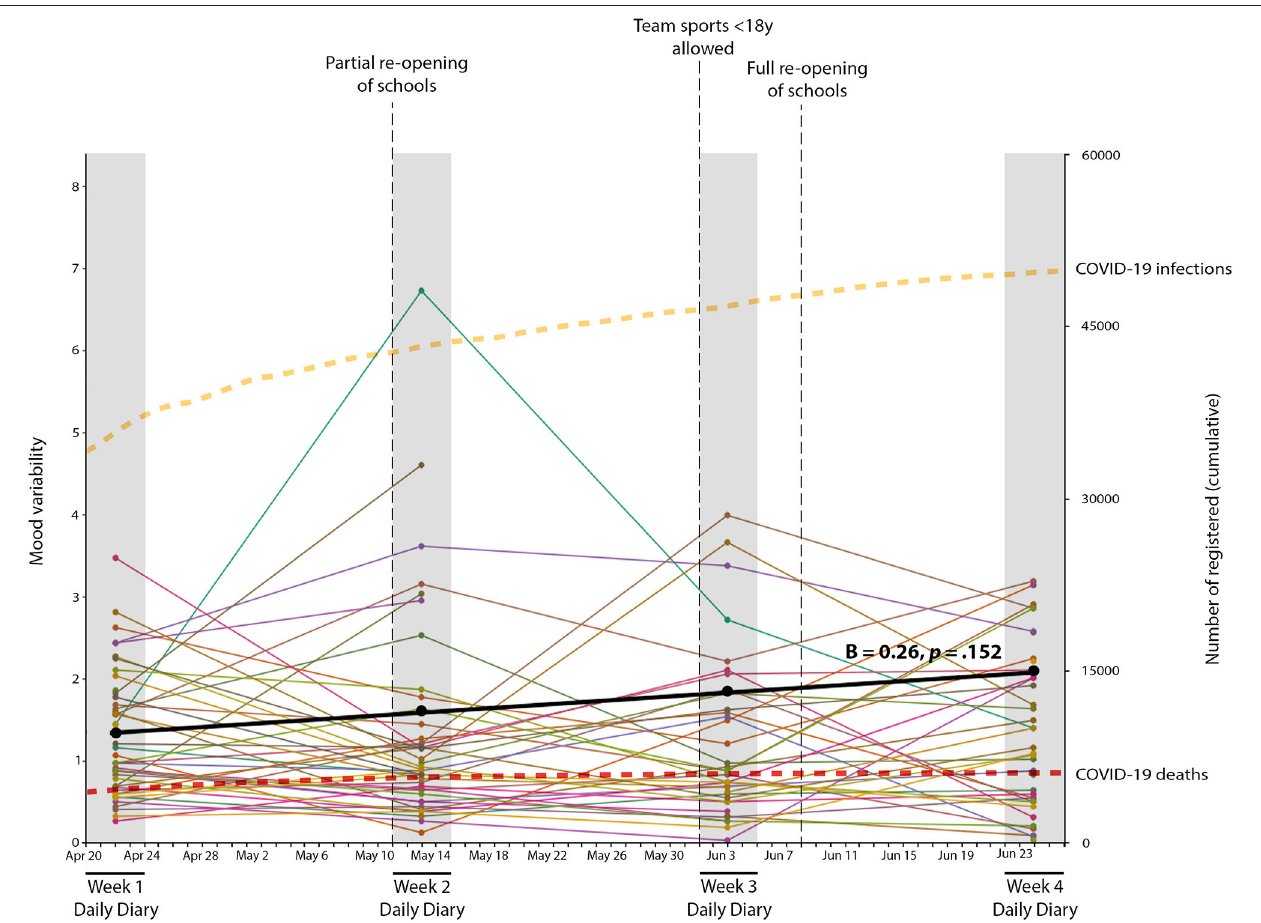
FIGURE 2 | Mean mood variability trajectory and individual trajectories during the first few months of the COVID-19 pandemic. The black line represents the optimal fitting model. Colored lines represent individual